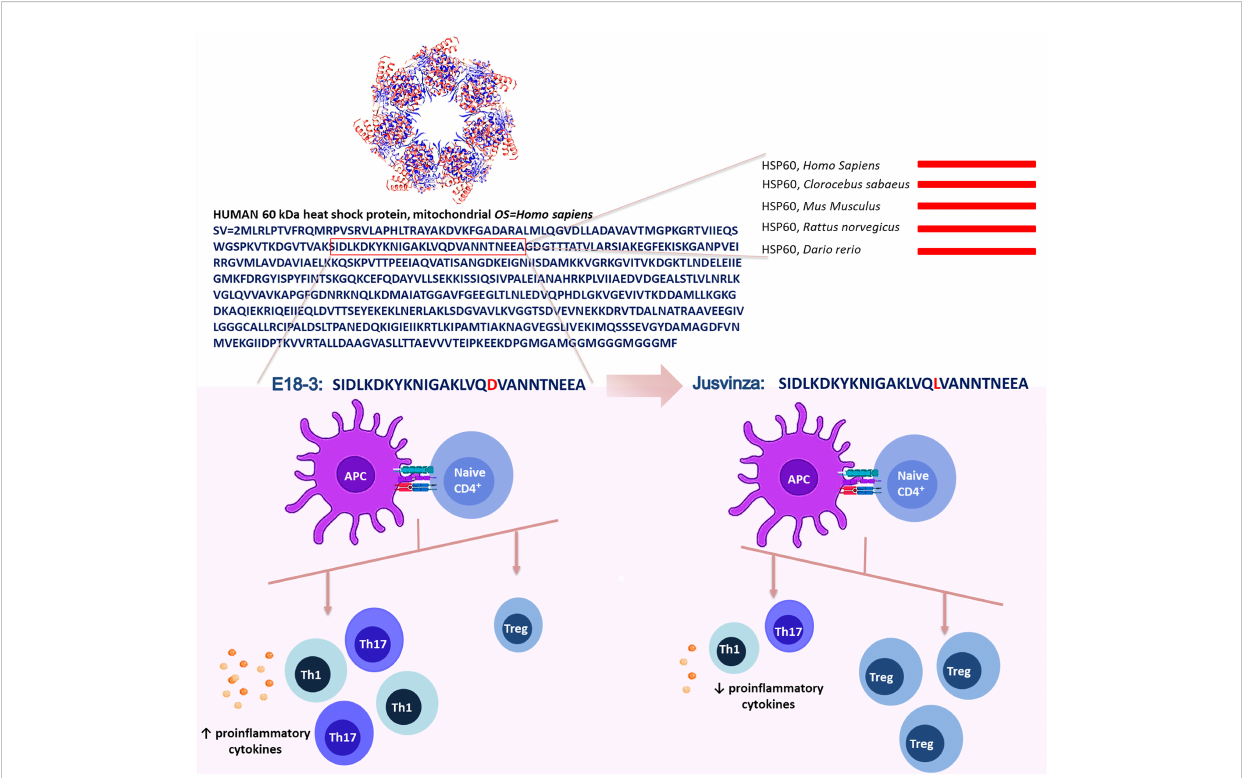
FIGURE 1 Jusvinza was designed from the N-terminal region of the human HSP60 (amino acids from 90 to 109). This sequence is 100% identical between humans, rats, mice, monkeys and Zebra fi sh (lines red). In this region, the aspartic acid-18 (red) involved in the interaction with the HLA class II molecule was substituted by leucine (red). This change increased the af fi nity between Jusvinza and HLA class II molecules. Jusvinza induces an increase of FOXP3+ regulatory T cells (Treg) and reduces proin fl ammatory cytokines. In contrast, the wild-type peptide did not induce Treg cells and increase proin fl ammatory